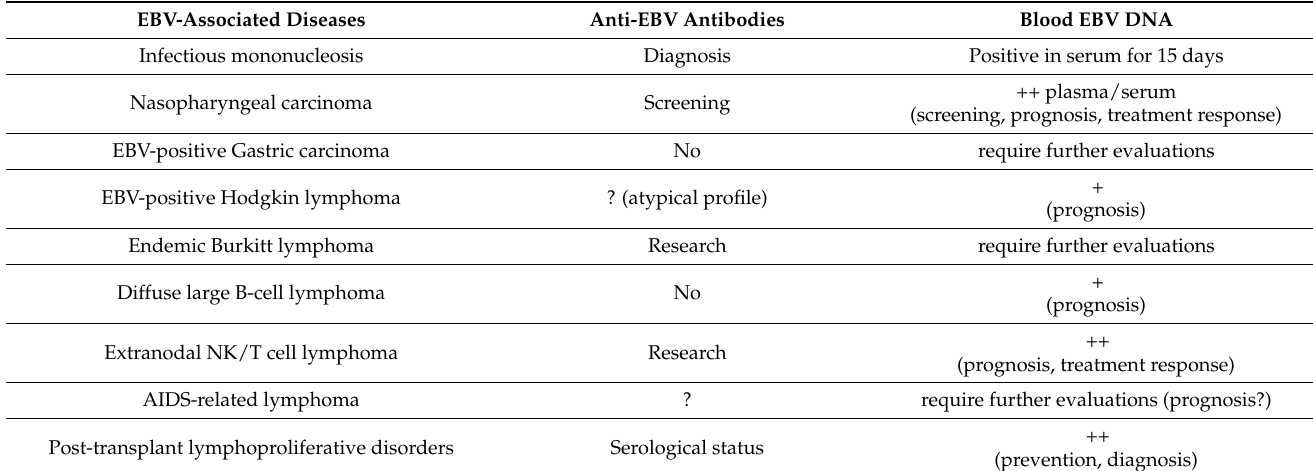
Table 4. Clinical utility of virological markers in EBV-associated